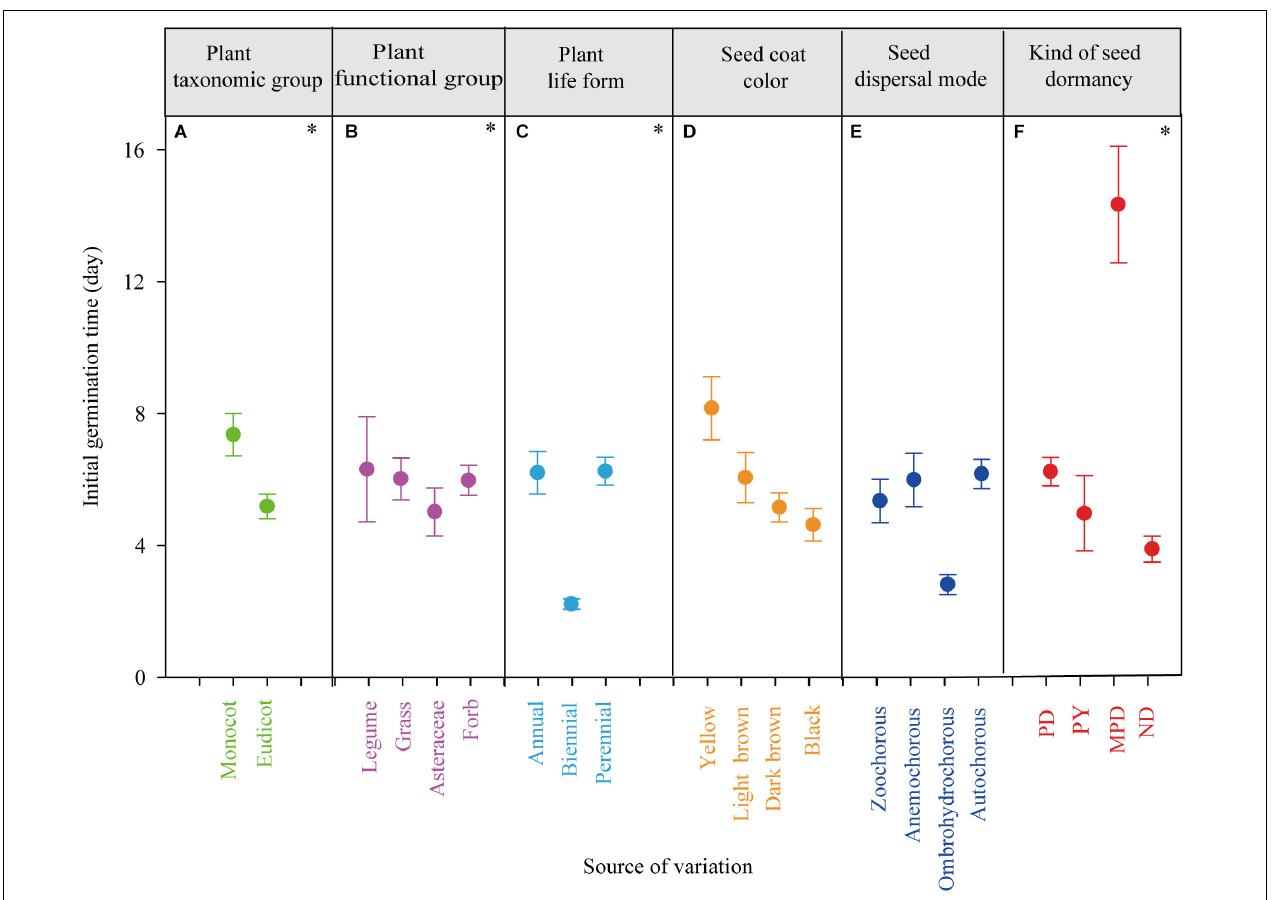
FIGURE 2 | The effects of plant taxonomic group (A) , plant functional group (B) , plant life form (C) , seed coat color (D) , seed dispersal mode (E) , and kind of seed dormancy (F) on initial germination time. PD, physiological dormancy; PY, physical dormancy; MPD, morpho-physiological dormancy; ND, non-dormancy. ∗ P < 0.05.